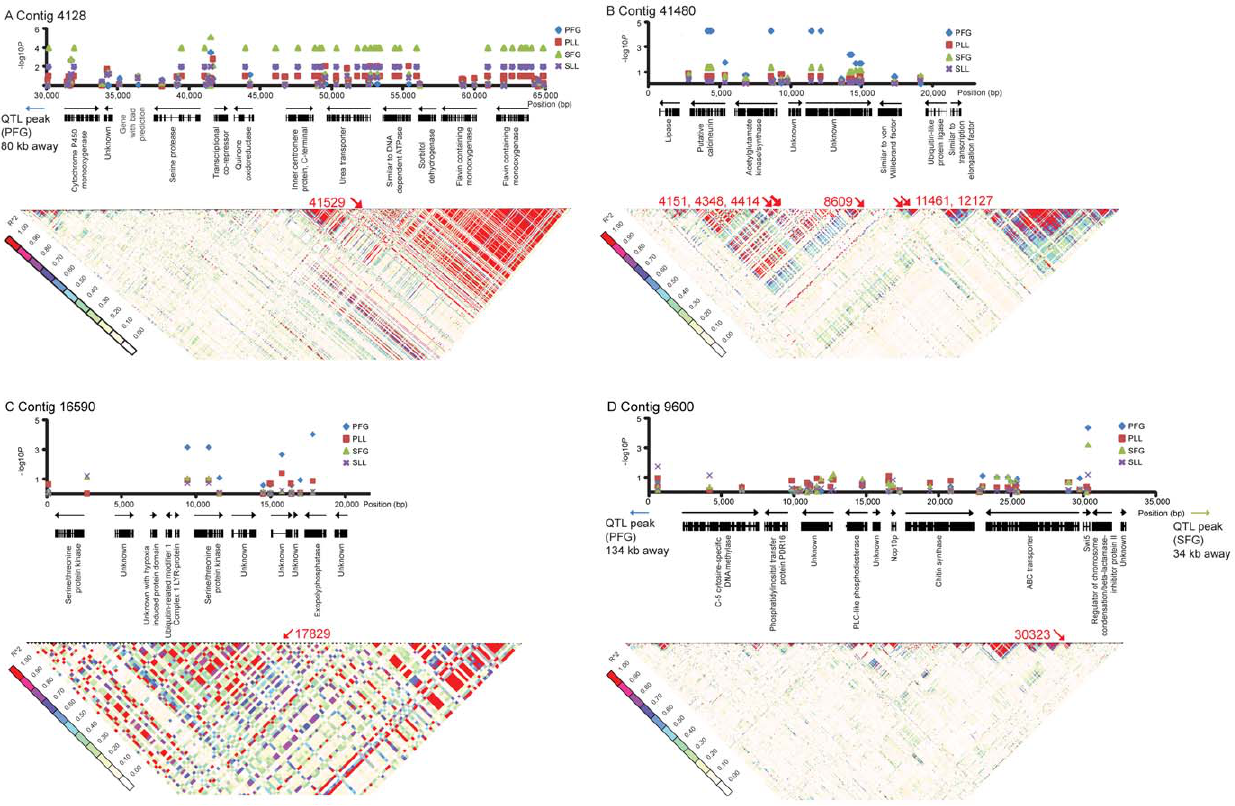
Figure 2. Overview of four genomic regions significantly associated with Heterobasidion virulence in spruce and pine. The upper part of each figure plots the p -values ( 2 log10 scale) for the four traits (up- and downstem combined) to the genomic position (in bp). Abbreviations: PFG, fungal growth in pine sapwood; PLL, lesion length in pine; SFG, fungal growth in spruce sapwood; SLL, lesion length in spruce. The lower part displays linkage disequilibrium (LD) heat maps. The heat map illustrates the LD value r 2 from white to red where red indicates high r 2 -values. Significant SNP markers are in red. (A) Contig 4128; (B) Contig 41480; (C) Contig 16590; (D) Contig 9600.